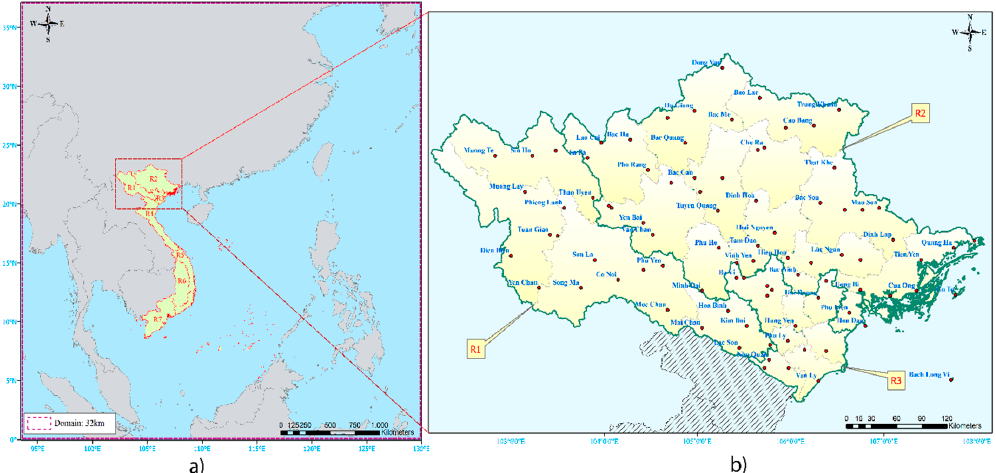
Figure 1. Research domain and subclimate regions in Vietnam (a), and a detailed view of northern Vietnam (NVN) with the surface observation distribution (red dots) (b).